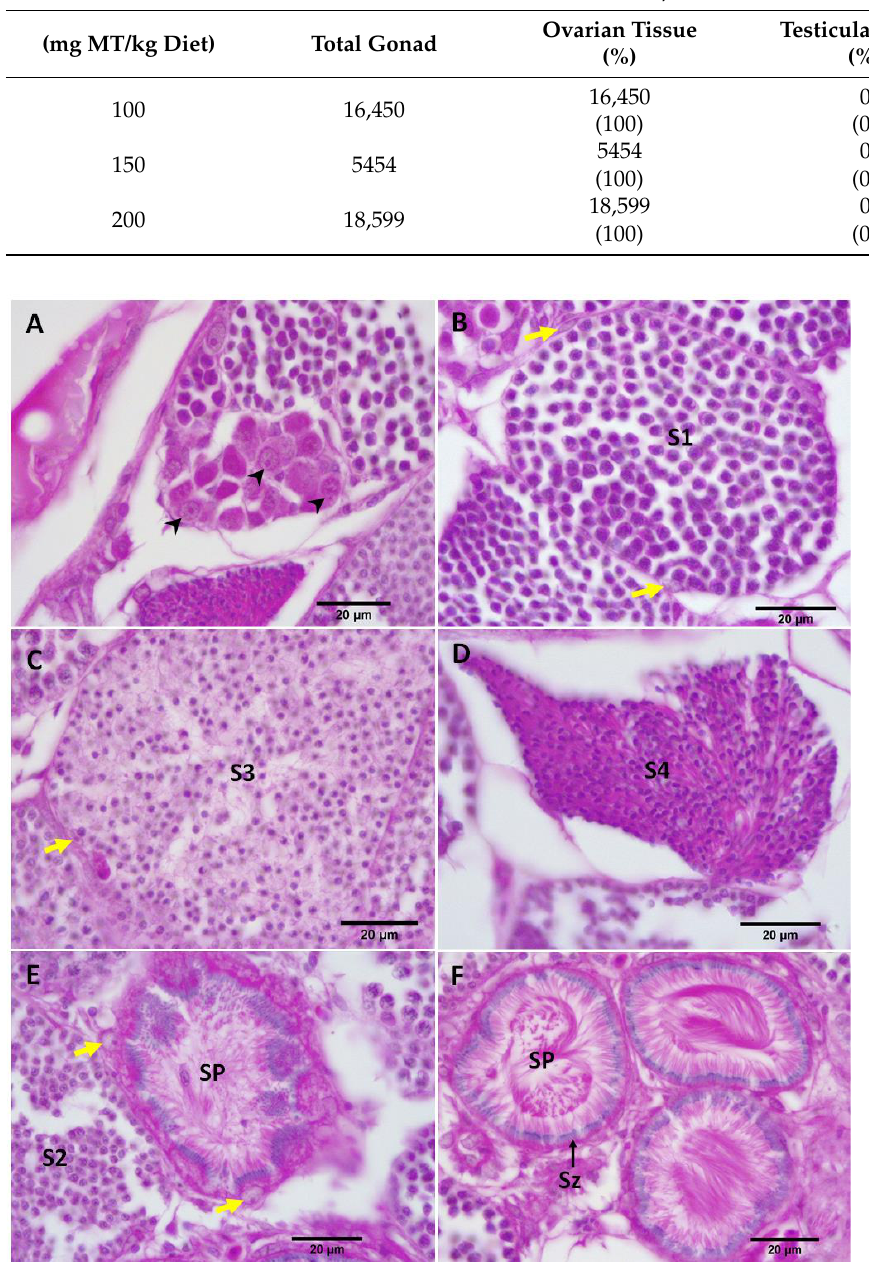
Figure 9. Sagittal sections through the gonad of the MG female treated with the 50 mg MT/kg diet at higher magnification: ( A ) spermatogonia (black arrowheads), ( B ) primary spermatocytes (S1), ( C ) early stage of spermatids (S3), ( D ) late stage of spermatids (S4), ( E ) secondary spermatocytes (S2) and early spermatozeugmata (SP) and ( F ) spermatozeugmata (SP) with the nuclei of the spermatozoa (Sz) oriented towards the periphery of spermatozeugmata. Sertoli cells are marked (yellow arrows). Table 2. Total gonad and testicular tissue areas of MG females treated with MT for a 50-day period ( n = 1 fish/treatment).